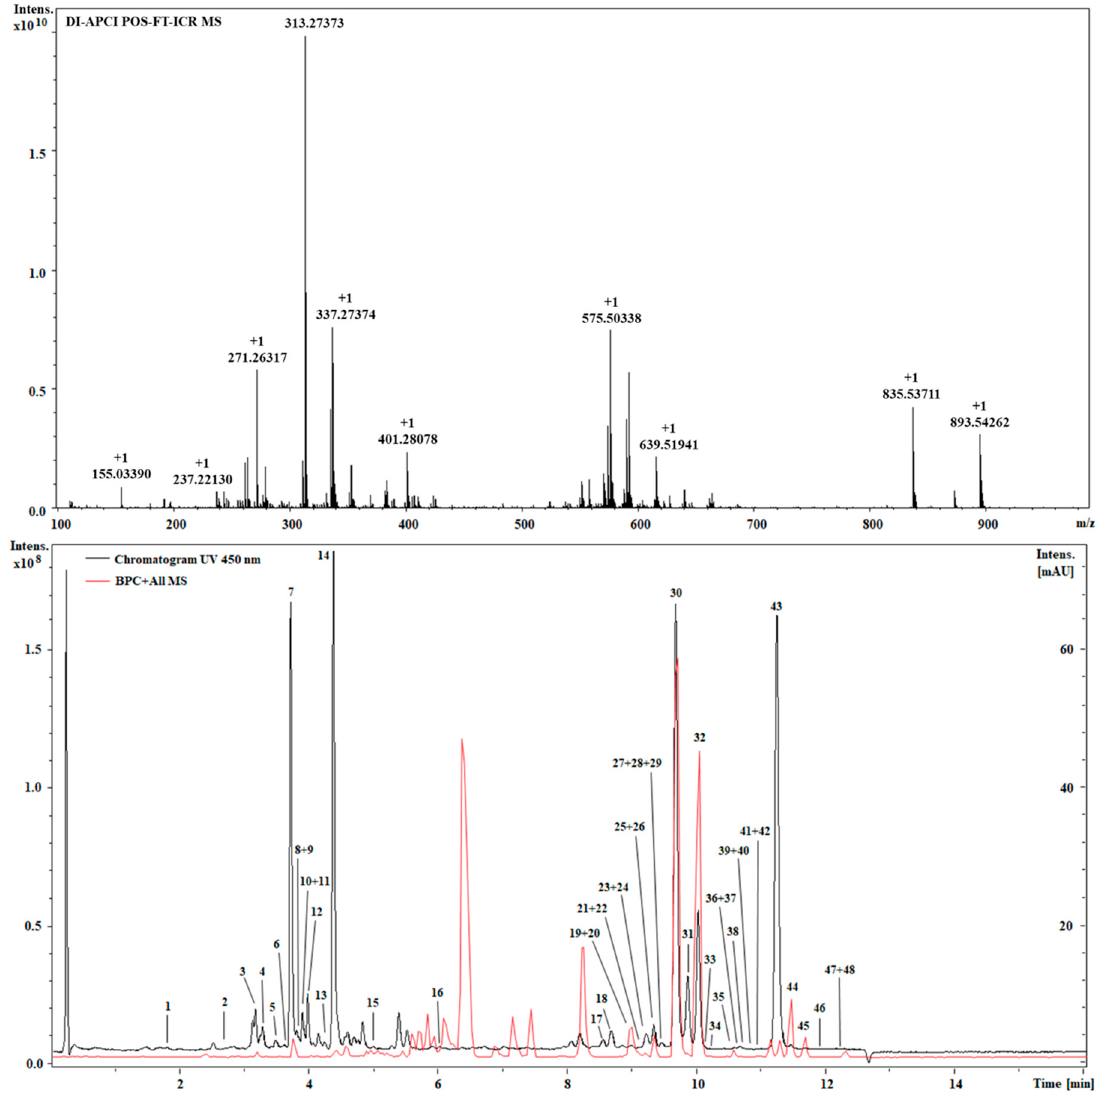
Figure 2. DIMS-APCI ( top ) and LC-APCI-FT-ICR MS ( bottom ) identification of Spirulina pigments.